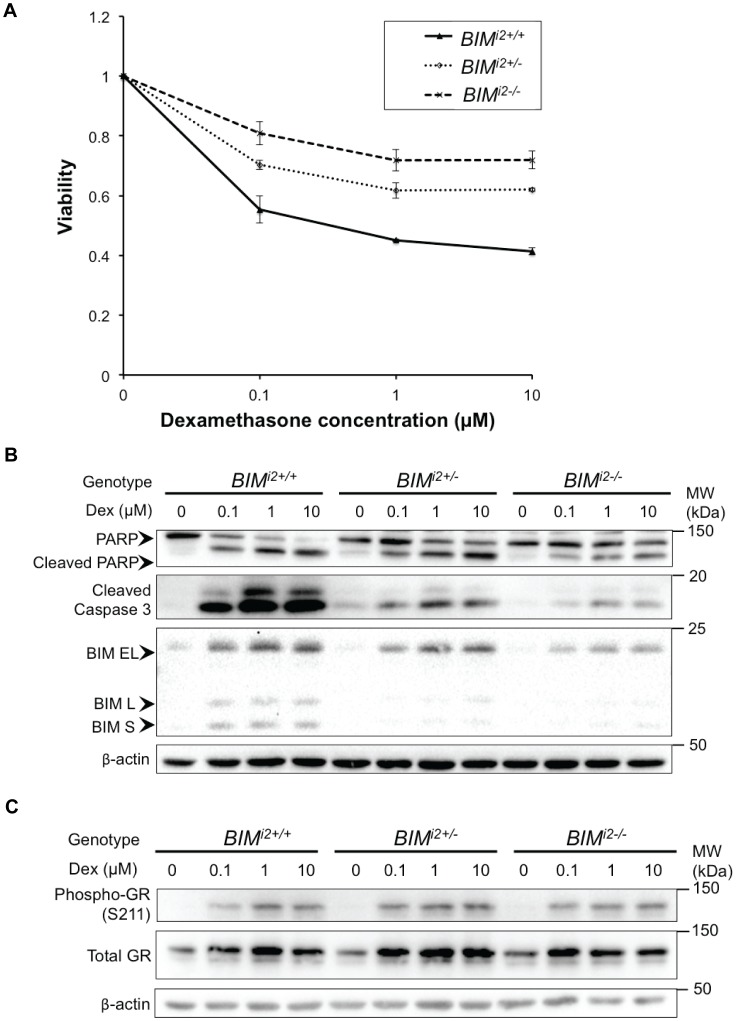
The BIM deletion confers dexamethasone resistance in CCRF-CEM cells.(A) Cell viability following exposure of CCRF-CEM subclones to increasing concentrations of dexamethasone. Viability was measured by MTS assay at 48 h. Error bars indicate mean ± SEM (n = 3) of 3 independent replicates. (B) Western blot of cell lysates from CCRF-CEM BIMi2+/+, BIMi2+/− and BIMi2−/− clones following treatment with increasing doses of dexamethasone for 48 h. The induction of cleaved PARP and cleaved caspase 3 were used as readouts for apoptosis. An antibody that recognizes pro-apoptotic exon-4 containing BIM isoforms (BIM EL, L and S) was used to show the extent of BIM upregulation following GC exposure. β-actin was used as a loading control. (C) Western blot showing phosphorylation of the glucocorticoid receptor (Phospho-GR S211) in CCRF-CEM BIMi2+/+, BIMi2+/− and BIMi2−/− clones upon treatment with dexamethasone.